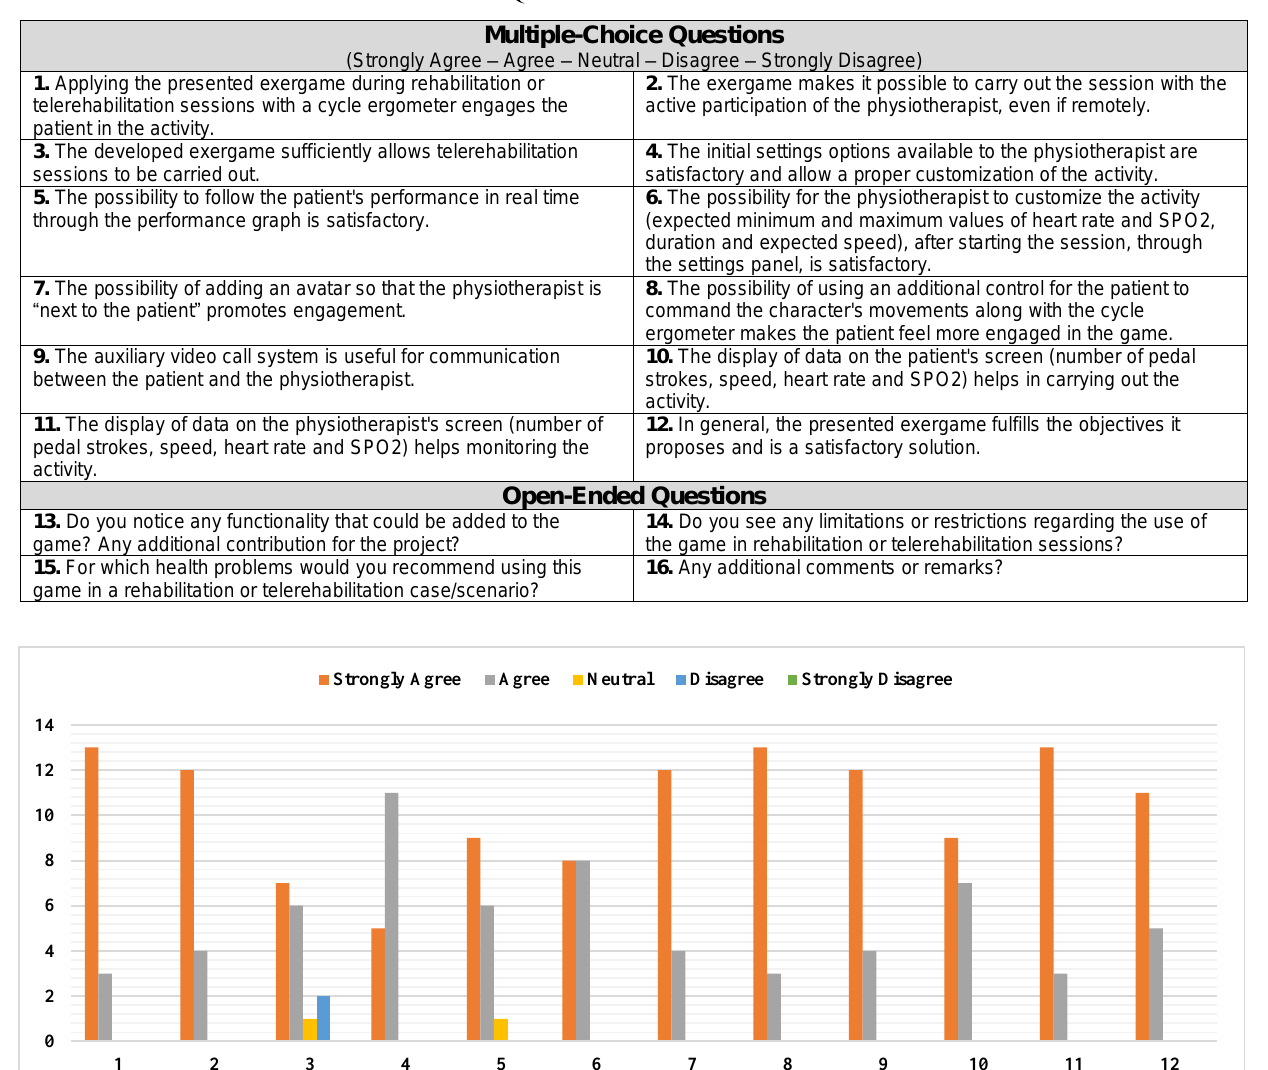
Table 2. Questions created for the evaluation.